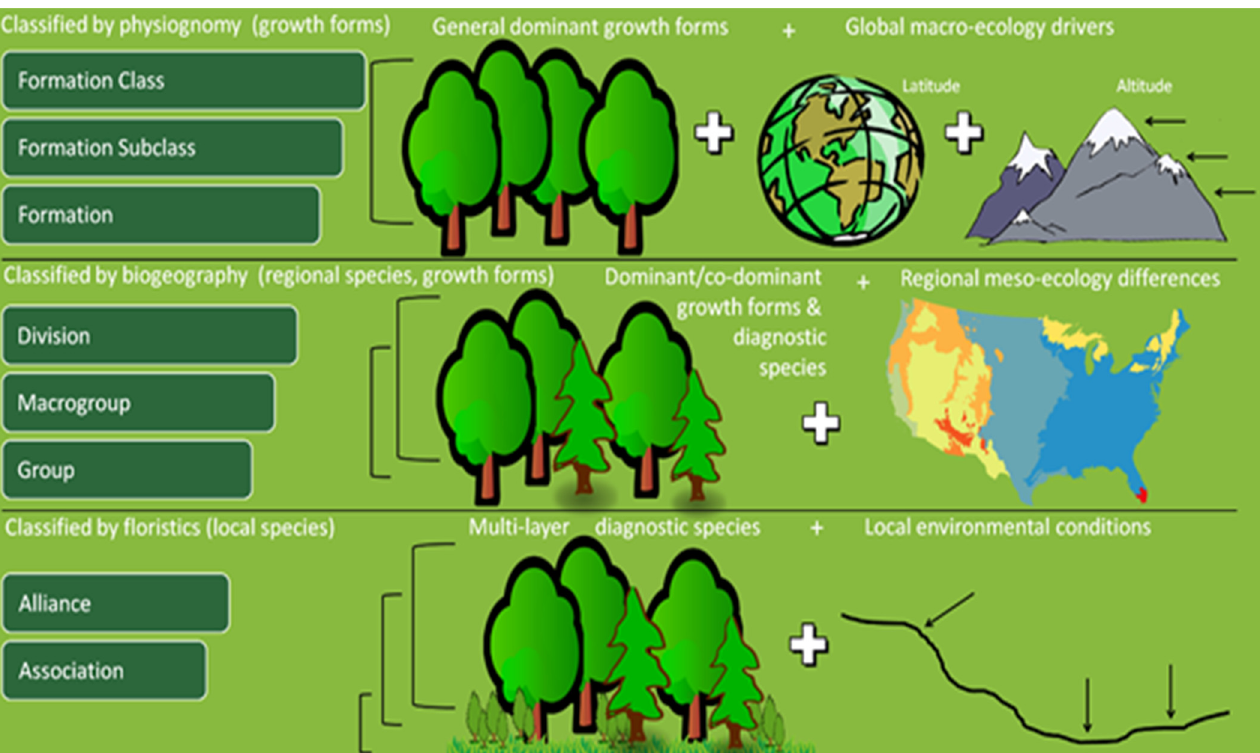
Figure 1. Graphical representation of the U.S. National Vegetation Classification [42], showing the biotic and abiotic factors used to classify vegetation at each level of the hierarchy. Graphic designed by Curtis M. Belyea, North Carolina Cooperative Fish and Wildlife Research Unit.